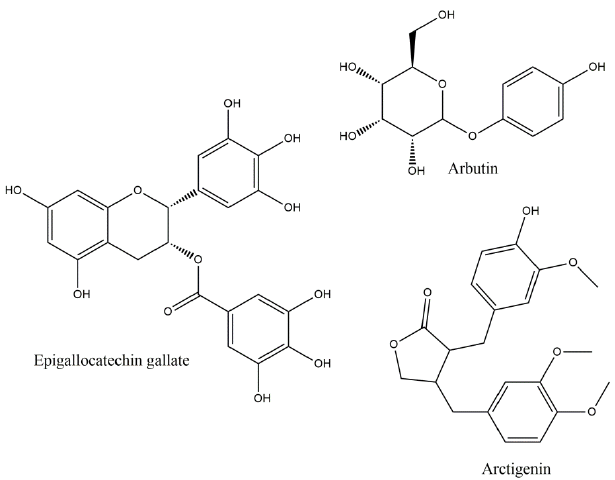
Figure 2. Epigallocatechin gallate, Arbutin and